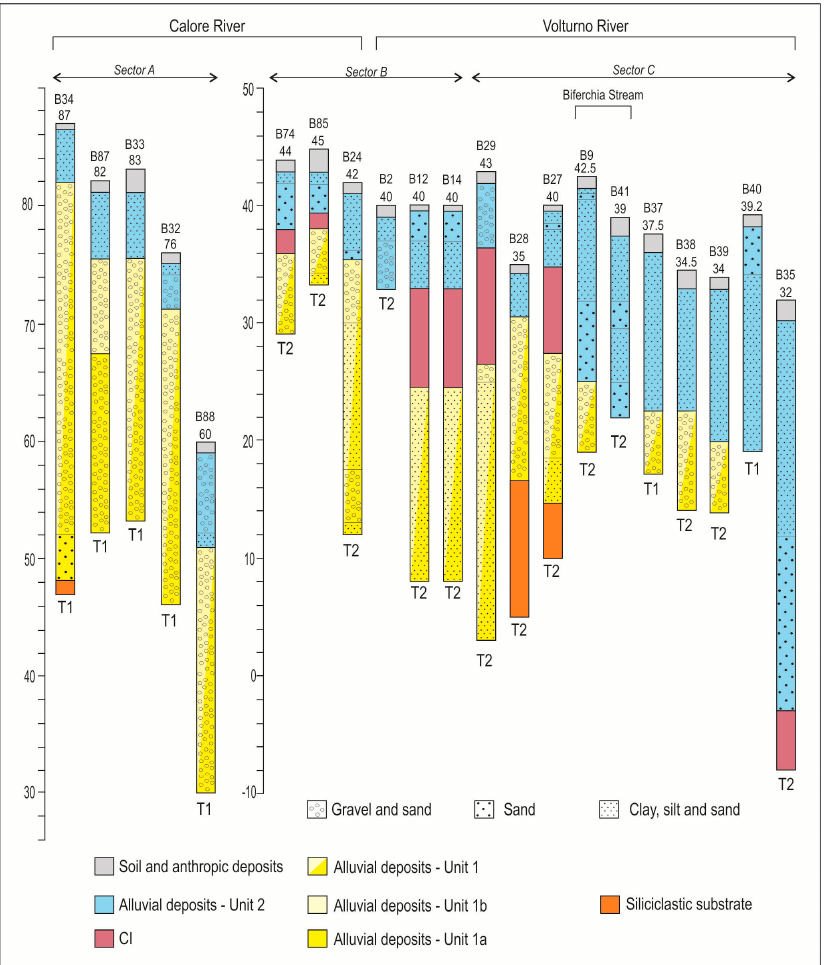
Figure 6. Calore and Volturno rivers longitudinal profiles and reconstruction of valley floor terraces T1–T3.